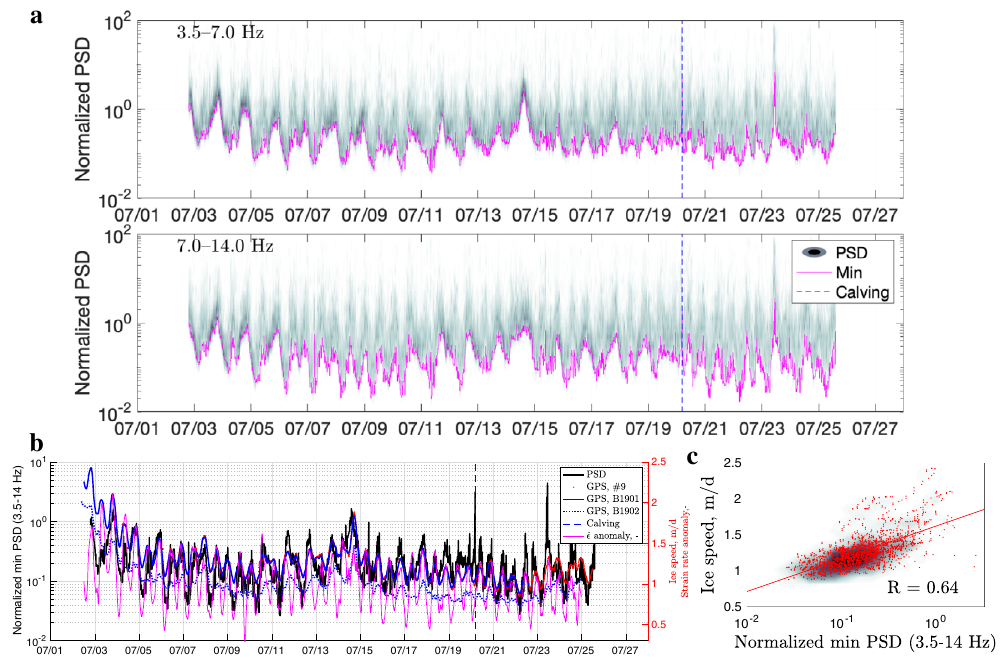
Fig. 8 Analysis of data from the 2019 on-ice seismic station (ATD). a Density plots of the normalized noise amplitude variations for 3.5 – 14.0 Hz frequency bands (for velocity power spectral density, PSD). Each magenta curve marks the lowest noise level in a given frequency band. The colour scale is the same as in Fig. 2c (0 – 35). The dashed blue line indicates the timing of a major calving event on 20 July. b Minimum seismic tremor amplitude (3.5 – 14.0 Hz) versus glacier displacement rate at Global-Positioning-System (GPS) stations B1901, B1902, and #9, with the corresponding strain rate anomaly, _ ϵ (i.e., deviation from the mean). The dashed blue line indicates the timing of a major calving event. c Scatter and density plots showing the correlation between the seismic signal and horizontal GPS displacement rate at B1901 for overlapping data ( R is the Pearson correlation coef fi cient). The red line is the regression fi